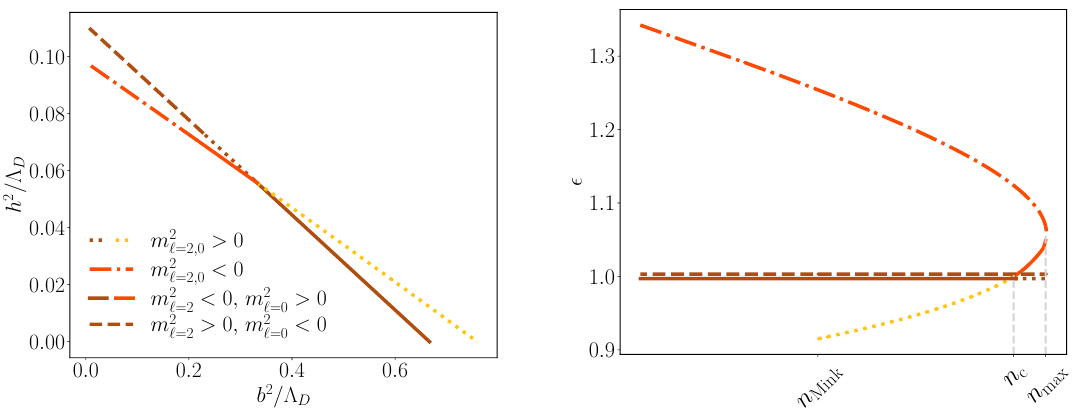
Figure 3 . Two branches of solutions to (2.49) in the ( b 2 / Λ D , h 2 / Λ D ) (left) and ( (cid:15), n ) plane (right). The brown lines represent the Freund-Rubin branch, while the yellow (oblate) and orange (prolate) lines represent the interpolation of warped solutions reconstructed numerically. The two branches 2 / Λ 2 / Λ intersect at ( b ) = (0 . 36 , 0 . 052) . The linestyle reflects the perturbatively unstable cr D , h cr D modes for the two branches. See figure 1 for more